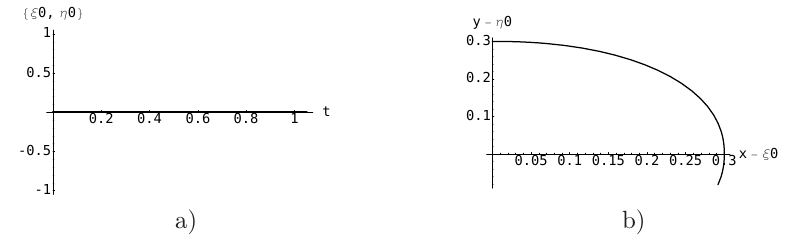
Figure 2. 0 -type solution ( ξ 0 ( t ) , η 0 ( t )) of the problem (5.1): a) the trivial solution ξ 0 ( t ) ≡ 0 , η 0 ( t ) ≡ 0 ; b) phase portrait of the difference between neighboring solution ( x ( t ; δ ) , y ( t ; δ )) and ( ξ 0 ( t ) , η 0 ( t )) , t ∈ [0 , 1] , if δ = 0 . 3 .